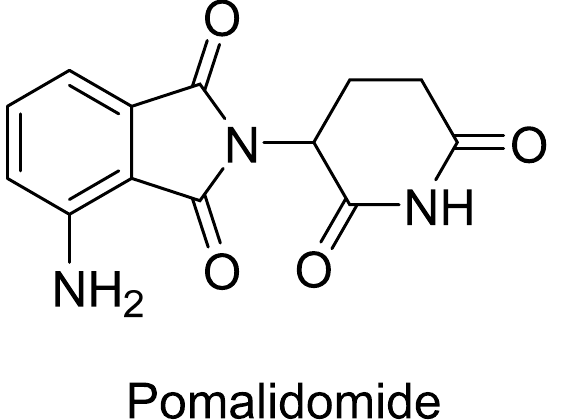
Figure 1. The structure of pomalidomide.